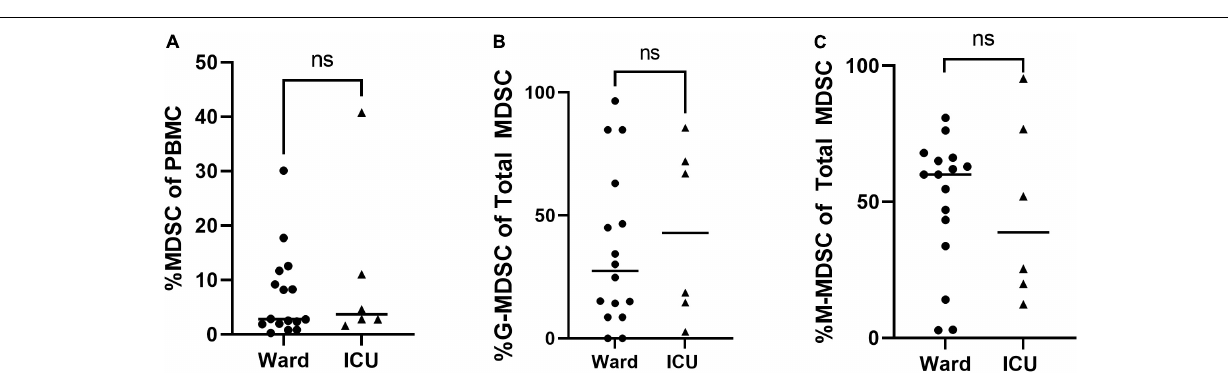
FIGURE 3 | Total MDSC and G- and M-MDSC subsets in children positive on universal screening. In children SARS-CoV-2 positive but asymptomatic for symptoms of acute COVID, there were no significant differences in subjects admitted to the floor vs. ICU in (A) Total (T-) MDSCs and (B) granulocytic (G-) MDSCs or (C) monocytic (M-) MDSCs. Mann-Whitney test was performed, data represent median with IQR. Ward ( N = 22), ICU ( N = 6). NS indicates p -value >